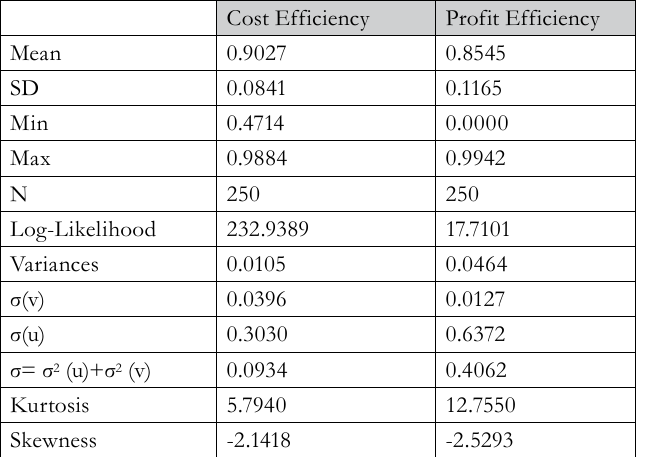
Tab.3 – Summary of cost and profit efficiency models. Source: author’s own calculation